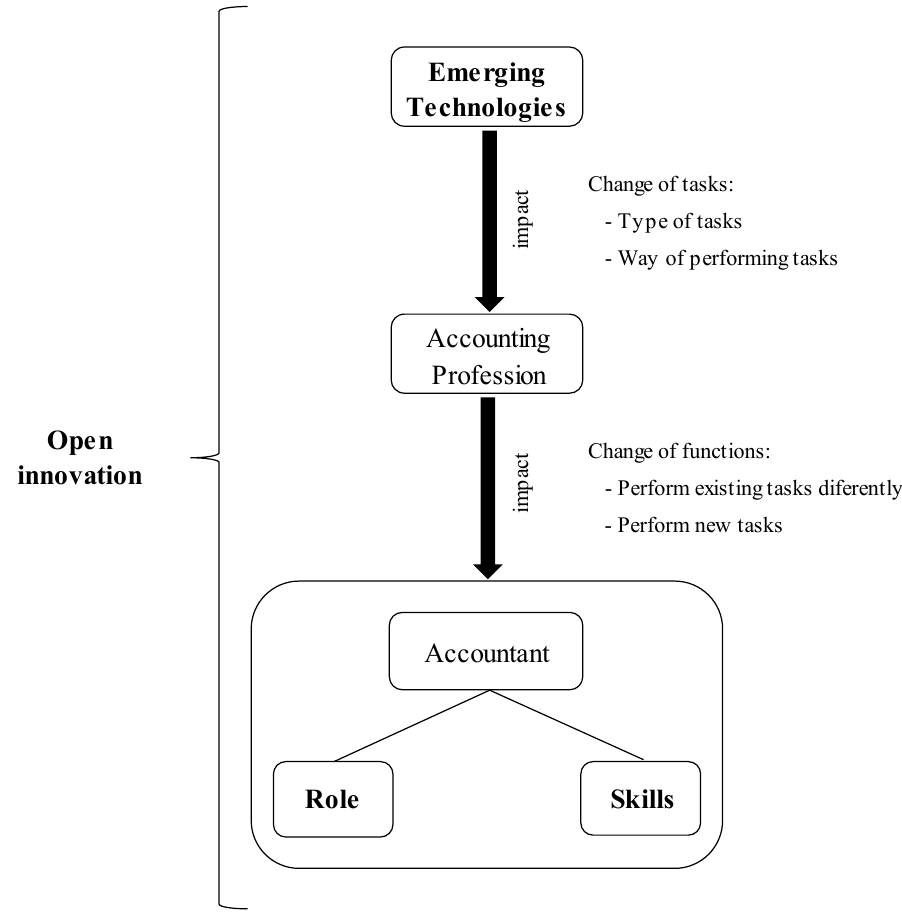
Figure 6. How do emerging technologies impact accountants’ role and skills?